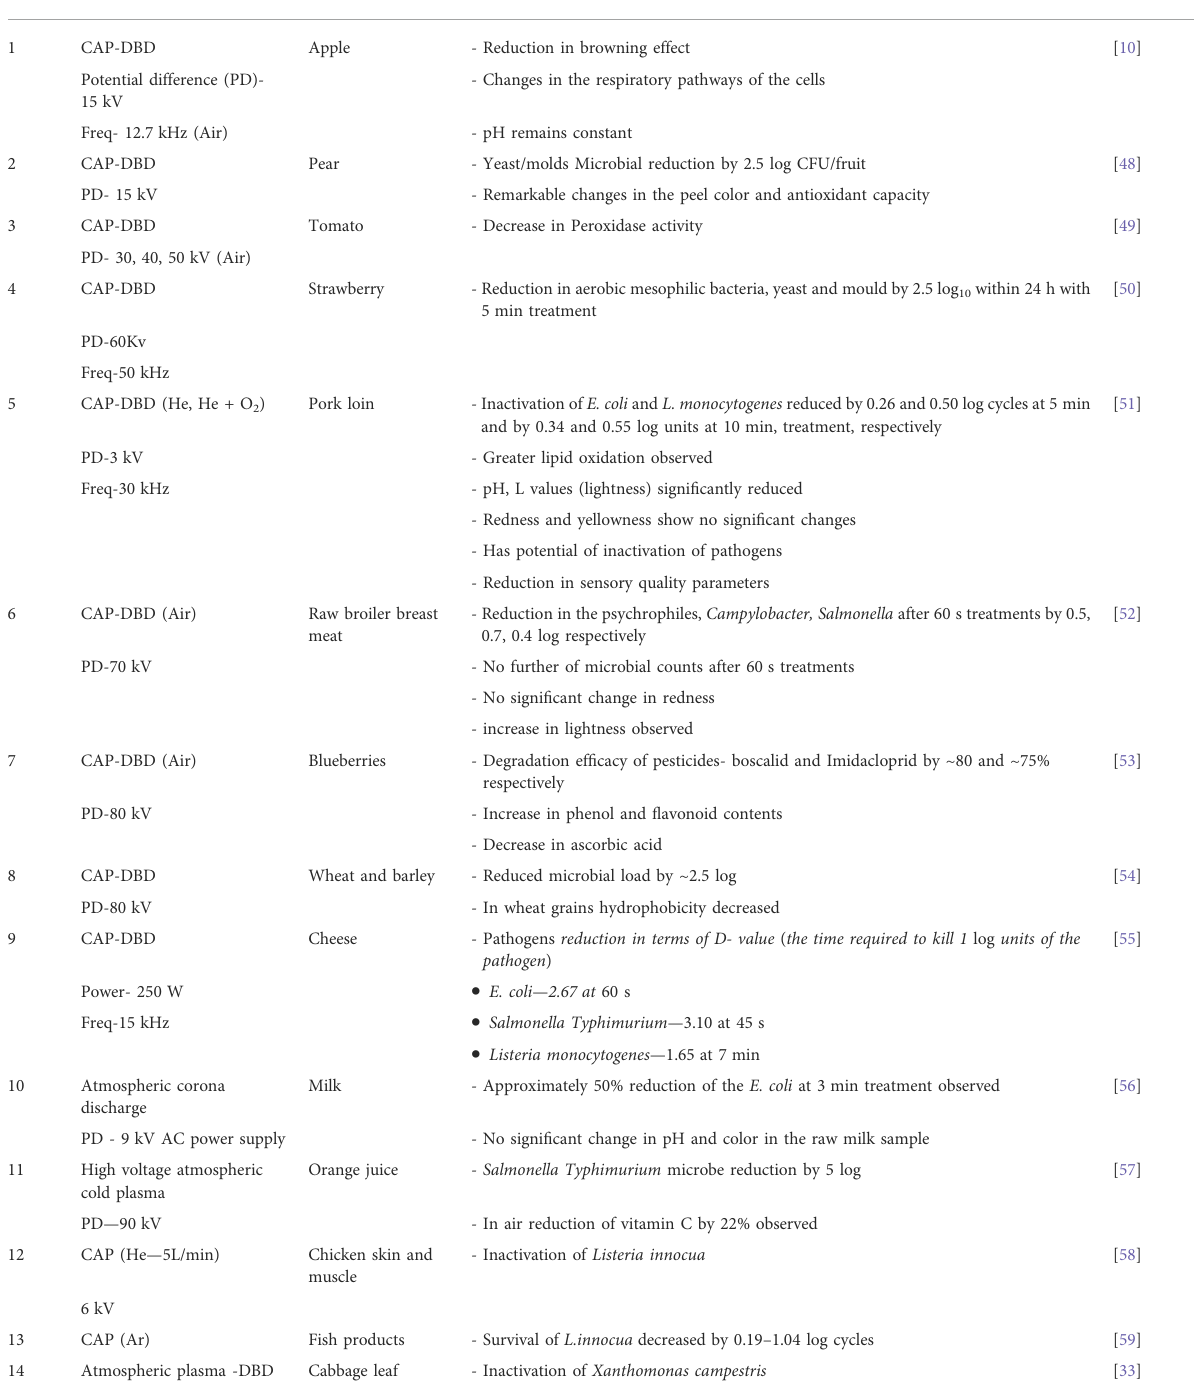
TABLE 1 Application of cold atmospheric plasma on eatables and the respective results. S.No.